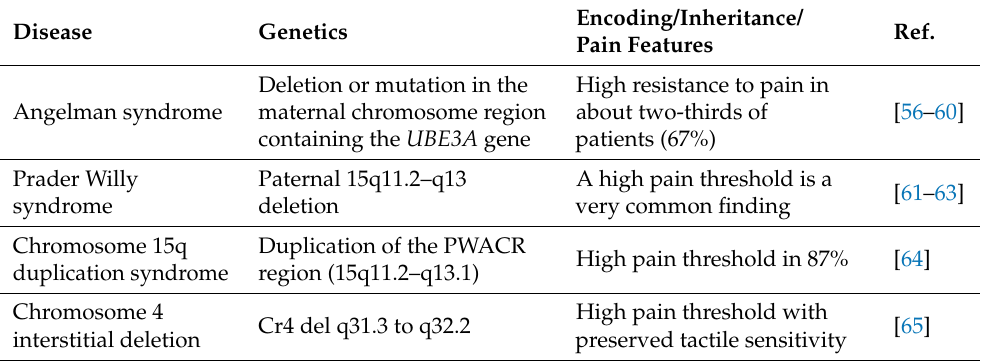
Table 3. Numeric/structural chromosomal abnormalities with reduced pain or insensitivity.